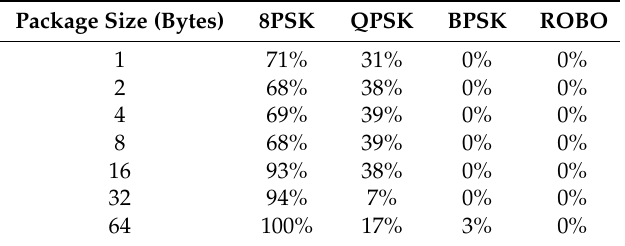
Table 4. Rate of received packets with errors in the tests performed with the 4 modulations. Package Size (Bytes) 8PSK QPSK BPSK